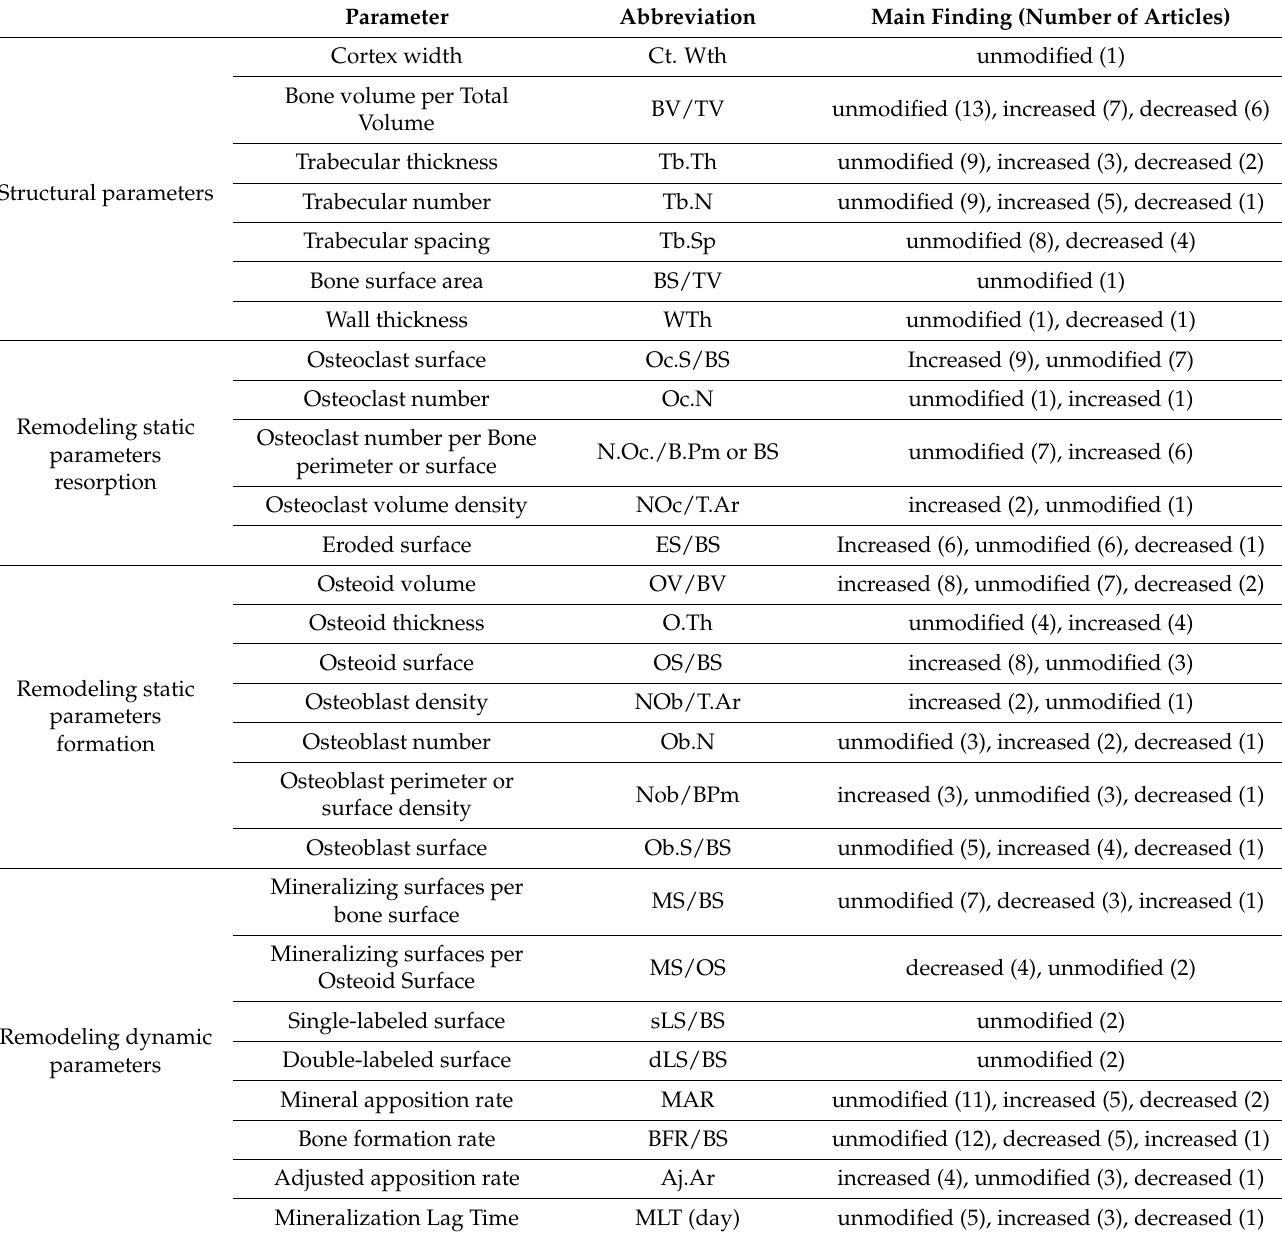
Table 3. Histomorphometric findings based on the articles reviewed and presented in Table 1. Only findings of mice with CKD on normal and high phosphate diets are depicted, but no findings from specific intervention